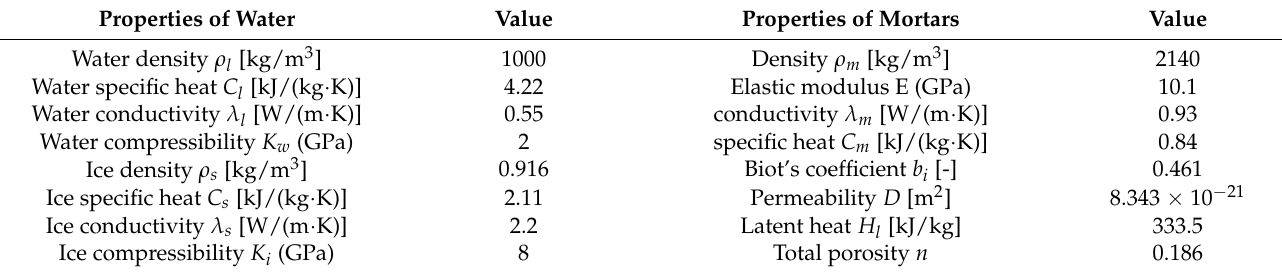
Table 1. Input material parameter adopted for